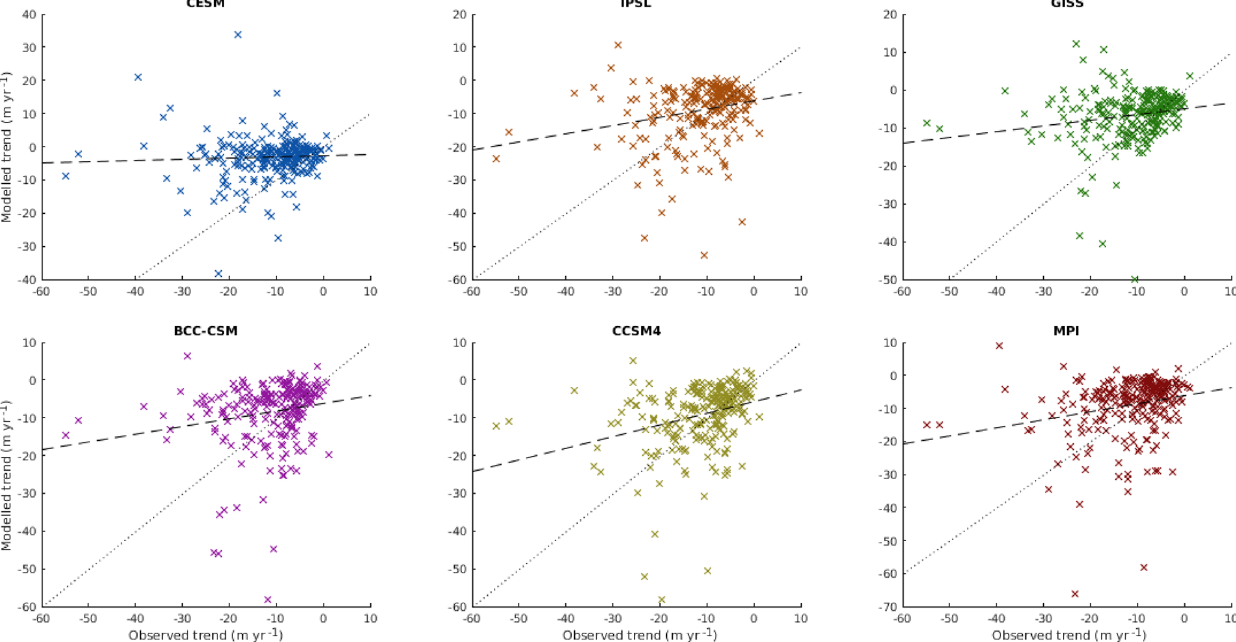
Figure 7. The 20th century length change trends: per-glacier modelled trends for OGGM runs driven by each GCM dataset vs. Leclercq et al. (2014) observations. The dashed black line is line of best fit, and the dotted black line shows the 1:1 ratio. Trends are calculated for all glaciers with at least 68 years in the 20th century covered by the observation period (68 years rather than the entire century was chosen to ensure more than 90% of glaciers are included). For glaciers with an observation period that starts before 1900, the trend is calculated only from 1900 onward, and for glaciers with an observation period that extends beyond 2000, the trend is calculated only up to